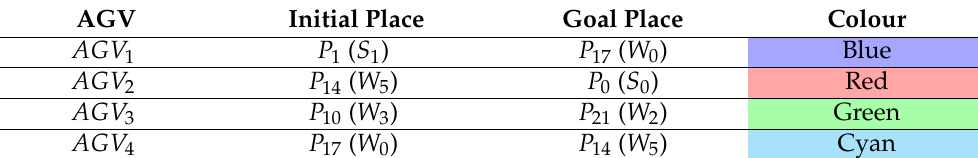
Table 2. Initial and goal places of the AGVs.